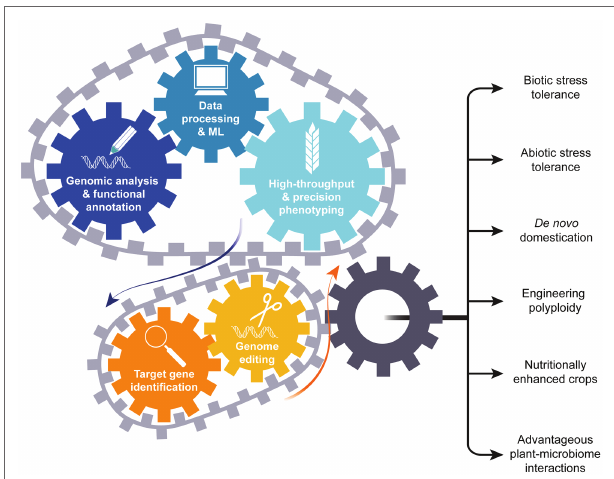
FIGURE 7 | Genomics drives development of climate change resilient crops. Knowledge obtained from genomics and high-throughput phenotyping drives candidate gene selection. Candidate genes can then be modified using genome editing resulting in generation of improved crop